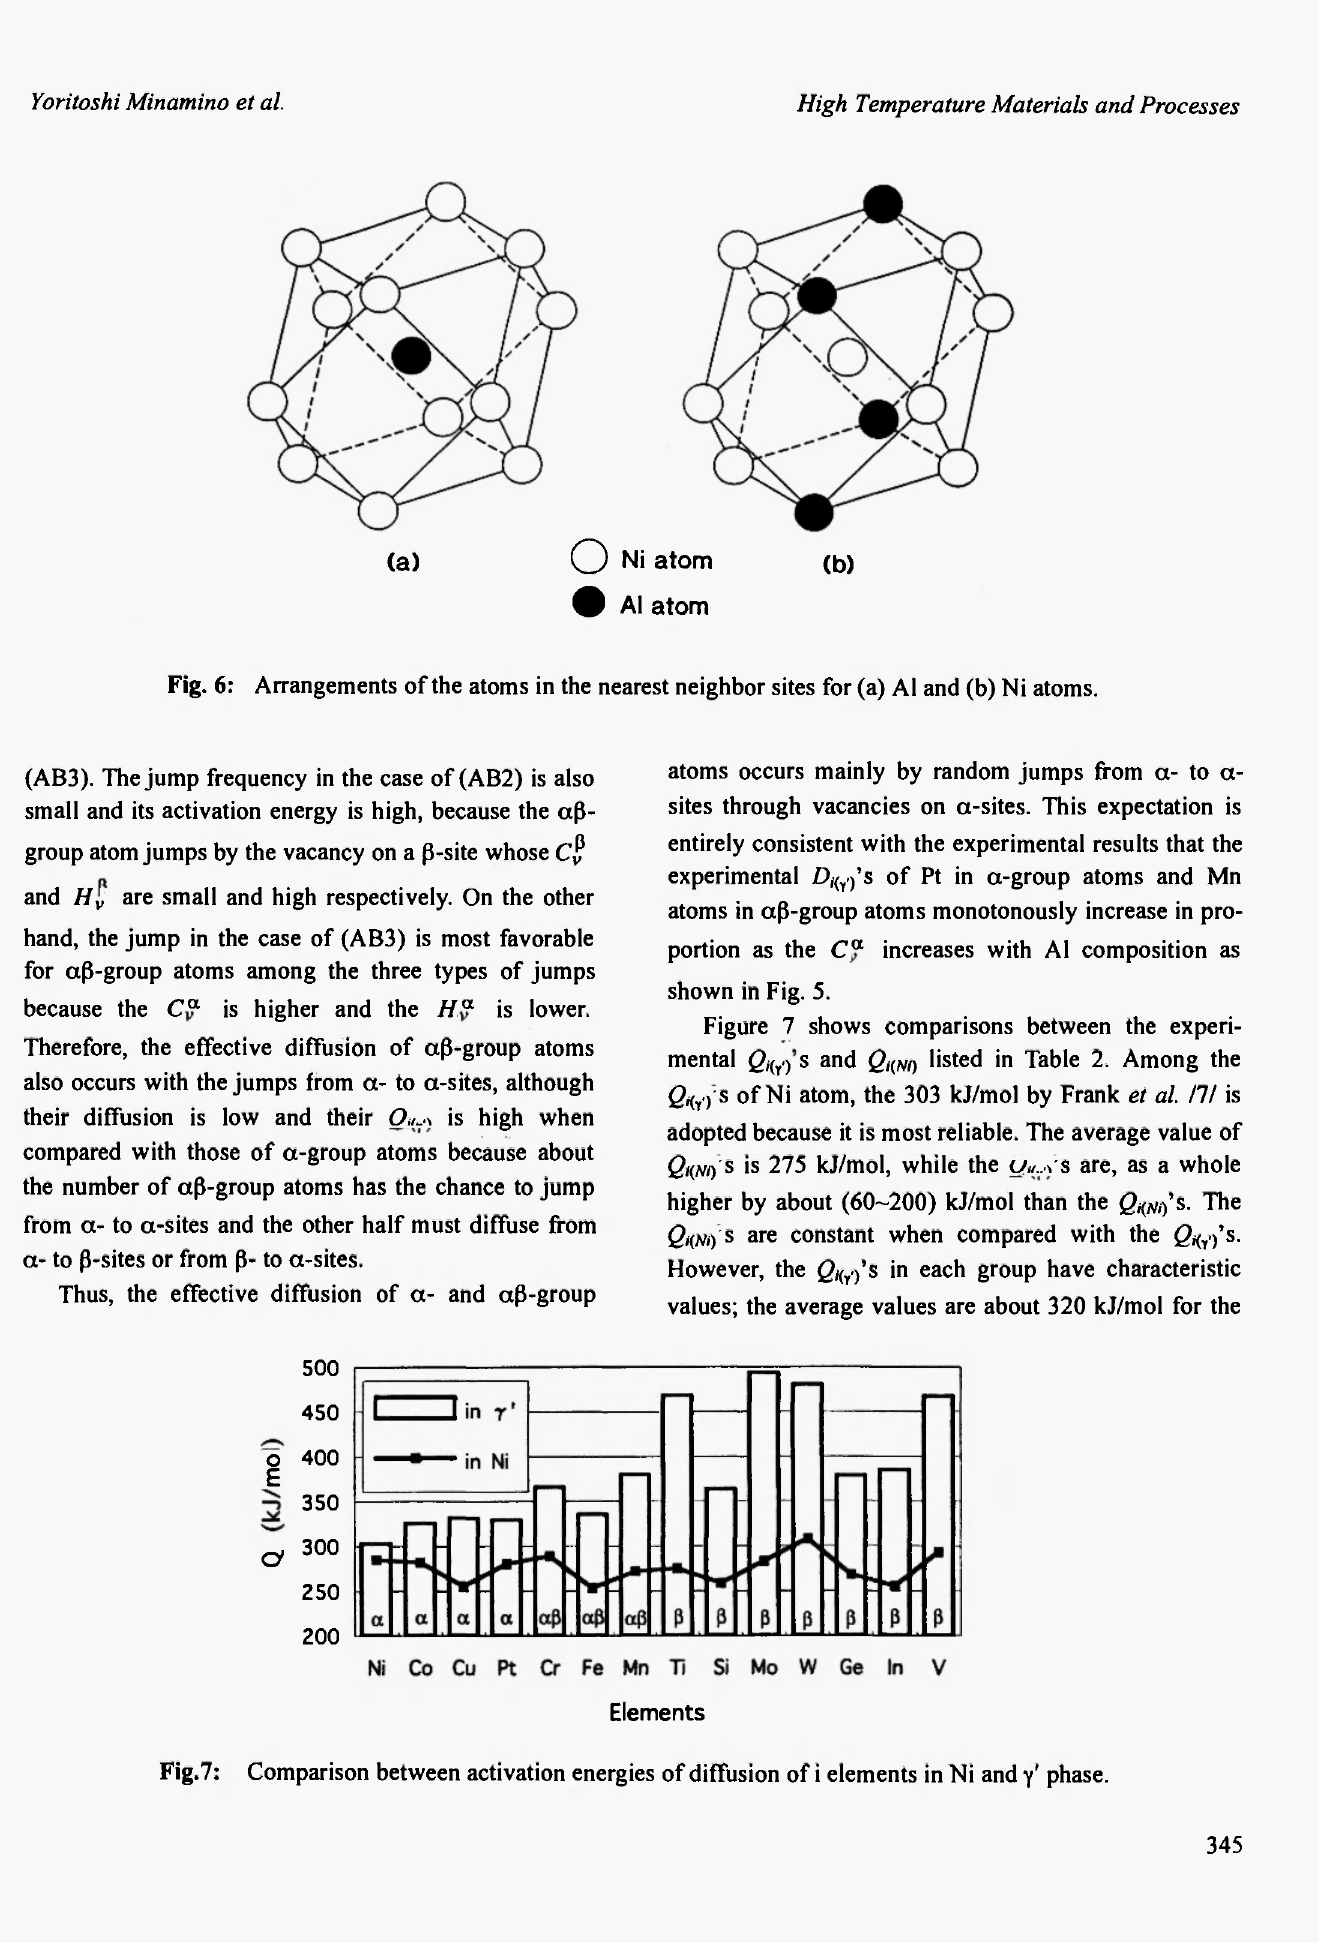
Fig .7: Comparison between activation energies of diffusion of i elements in Ni and γ'